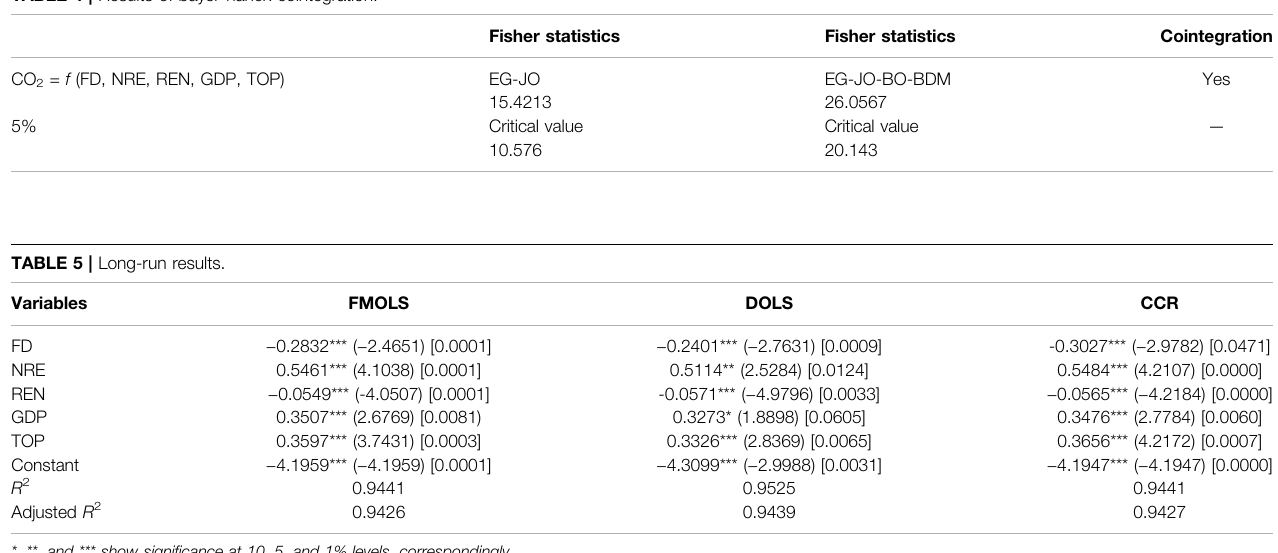
TABLE 4 | Results of bayer-hanck cointegration.